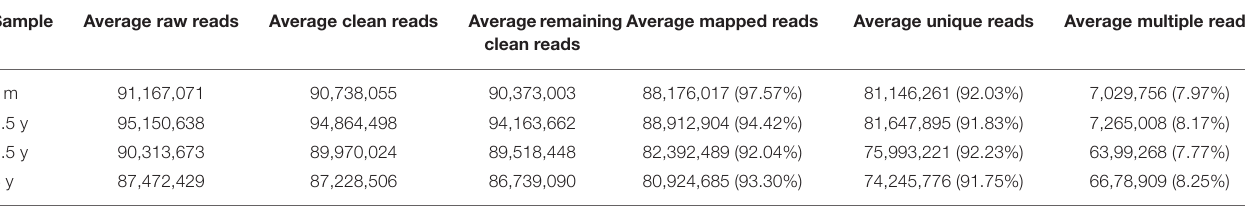
TABLE 2 | The summary of the RNA-Seq data.